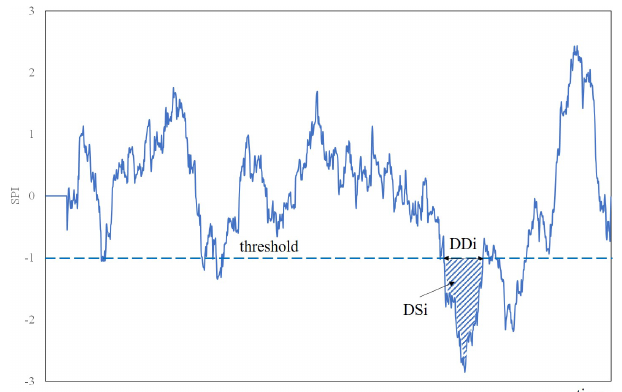
Figure 2. Drought characteristic identification using the “run the- ory” (Yevjevich,